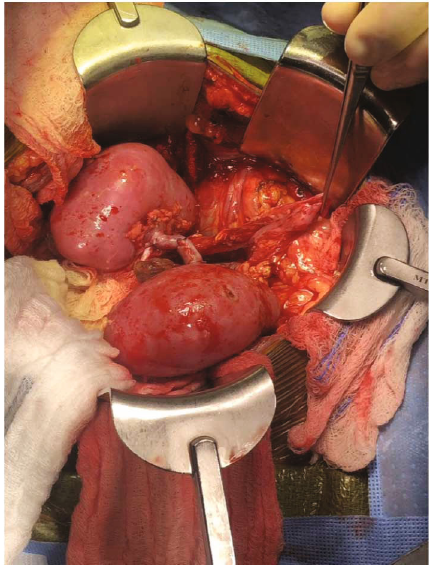
Figure 3: EBPK allograft placed in situ after transplantation. The vascular anastomoses between the aorta and IVC and recipient external iliac vessels have been fi nished. EBPK: en bloc pediatric kidneys; IVC: inferior vena